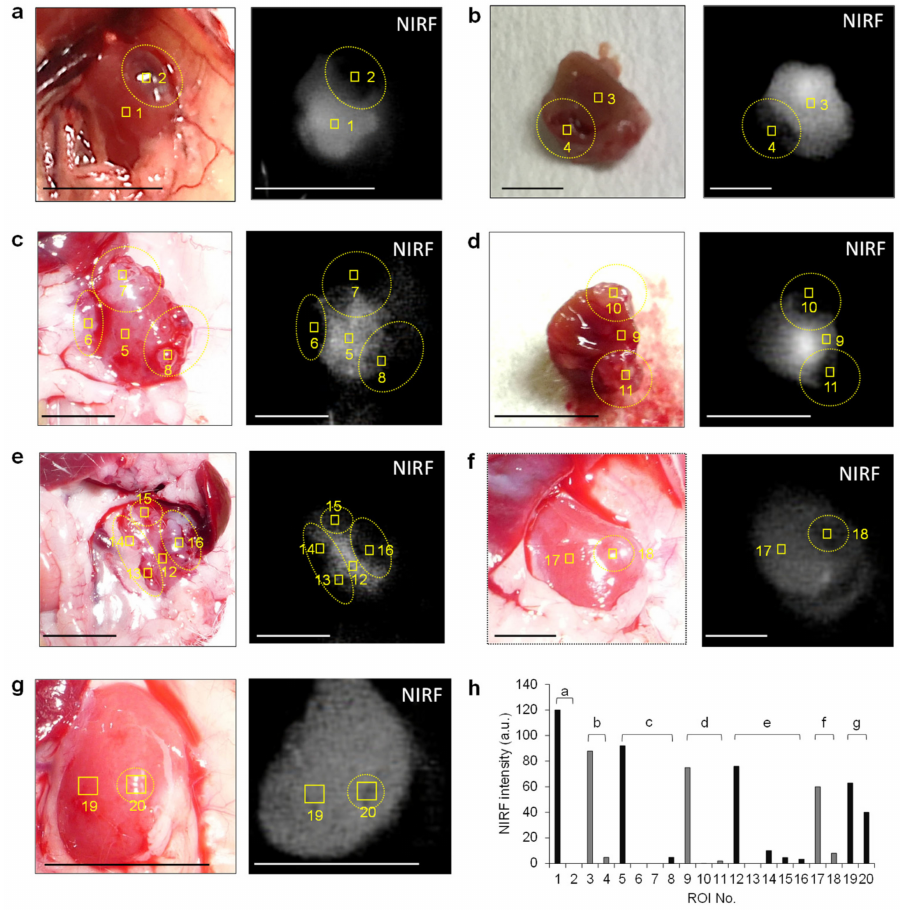
Figure 3. In vivo and ex vivo near-infrared fluorescence (NIRF) imaging of cancerous kidneys. Images were obtained at 10 min after the intravenous administration of ASP5354 (12 nmol/kg body weight) in mice. ( b ) Section of the cancerous kidney shown in image ( a ). ( d ) Section of the cancerous kidney shown in image ( c ). ( h ) Mean NIRF intensity in ROI shown in squares in images ( a – g ). Cancer tissues are in the dotted circles. NIRF is displayed in white. Scale bar = 10 mm.